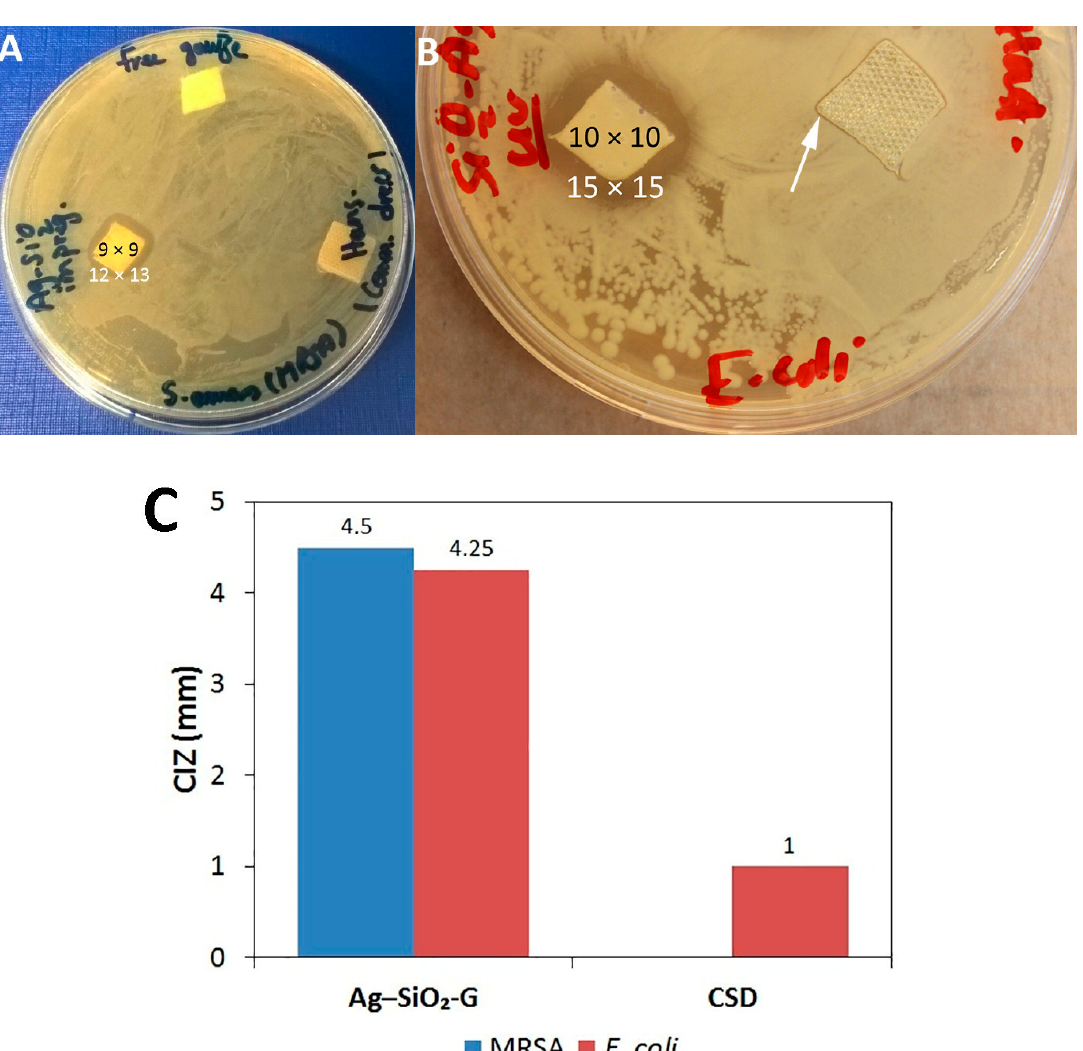
Figure 5. ( A , B ) Antibacterial effects of Ag–SiO 2 composite-impregnated gauze (Ag–SiO 2 -G) against MRSA ( A ) and E . coli ( B ) in the agar diffusion assay. The black and white numbers represent the sizes of the dressings and the produced IZs in mm, respectively. The white arrow points to the small IZ produced by the commercial Ag-containing dressing (CSD) (Hansaplast) against E . coli . ( C ) The corrected inhibition zones (CIZs) of Ag–SiO 2 -G and CSD.